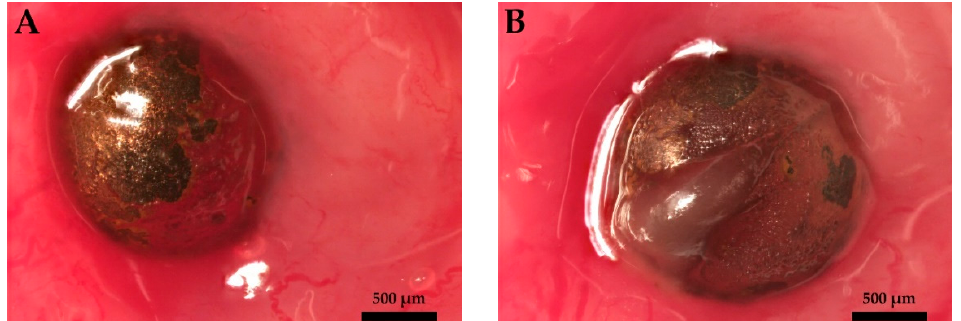
Figure 4. Rat urinary bladder implants. Sampling on postoperative day 7. Large protein layers were observed on the surfaces of the implants. The copper coating remained on the entire surface of the coated glass bead. ( A ): Borosilikate glass, 2.0 mm bead, copper coating, 1.0 µm, ( B ): copper grade 200, 2.0 mm solid copper bead, O.F.H.C copper, 99.9%, oxygen-free.